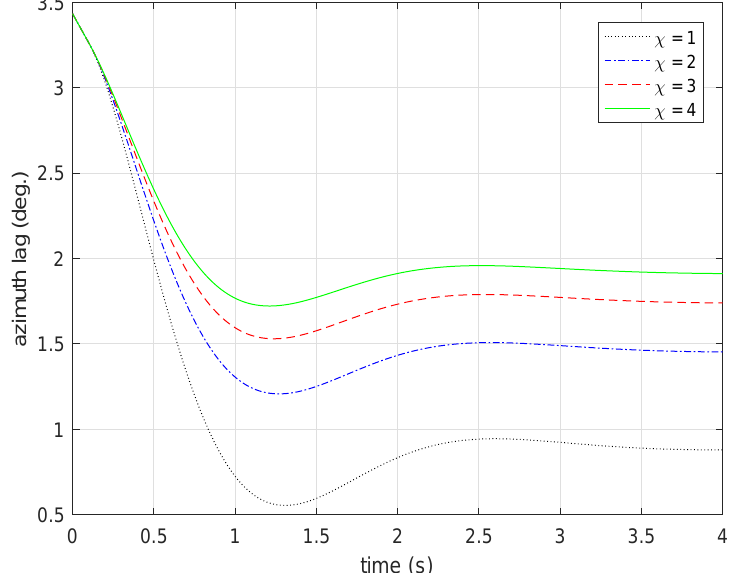
Figure 18. The azimuth lag for target A in a two target scenario with both sources providing a continuous wave jamming signal at different relative